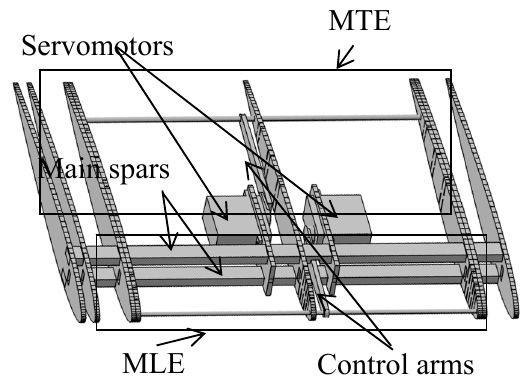
Figure 8. MCS internal assembly.